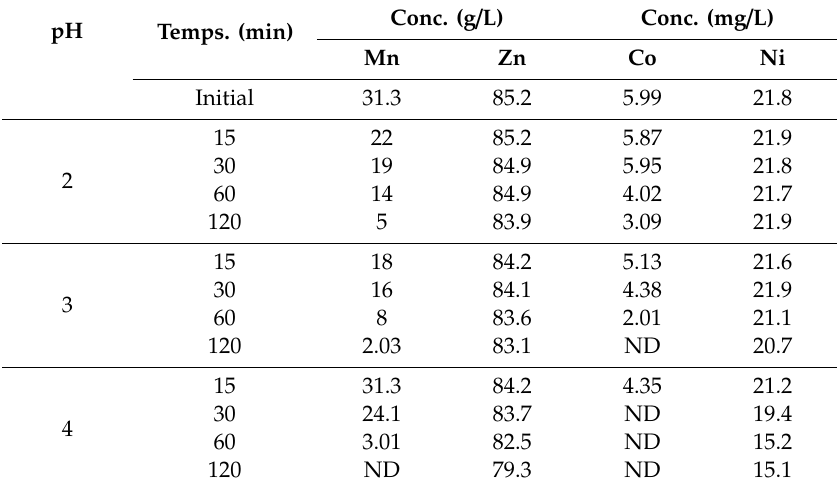
Table 8. Oxidation kinetics of Mn 2 + to MnO 2 in di ff erent